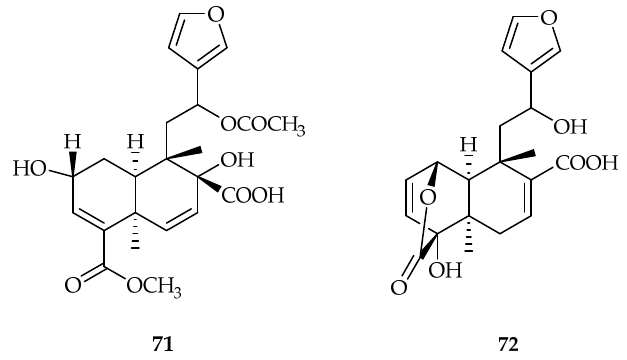
Figure 29. Structures of sheareria D 68 [45], scutebata C 1 69 [46], and ajugacumbin N 70 [47]. Two new cis -clerodane-type furanoditerpenes, crispenes F 71 and G 72 , with STAT3 (signal transducer and activator of transcription protein 3) inhibitory activity, were iso- lated from the stems of Tinospora crispa (Menispermaceae) (Figure 30). Compounds 71 and 72 showed IC 50 values of 10 and 7.8 μM against the MDA-MB-231 (STAT3-dependent) cell line, respectively. The results suggested a STAT3-specific inhibition. The compounds were also tested against a non-tumor lung fibroblast cell line, WI-38, but did not show any toxicity at the highest concentration (100 μM) tested. A molecular modeling study was carried out to better understand the molecular mechanism of actions of 71 and 72 [48].